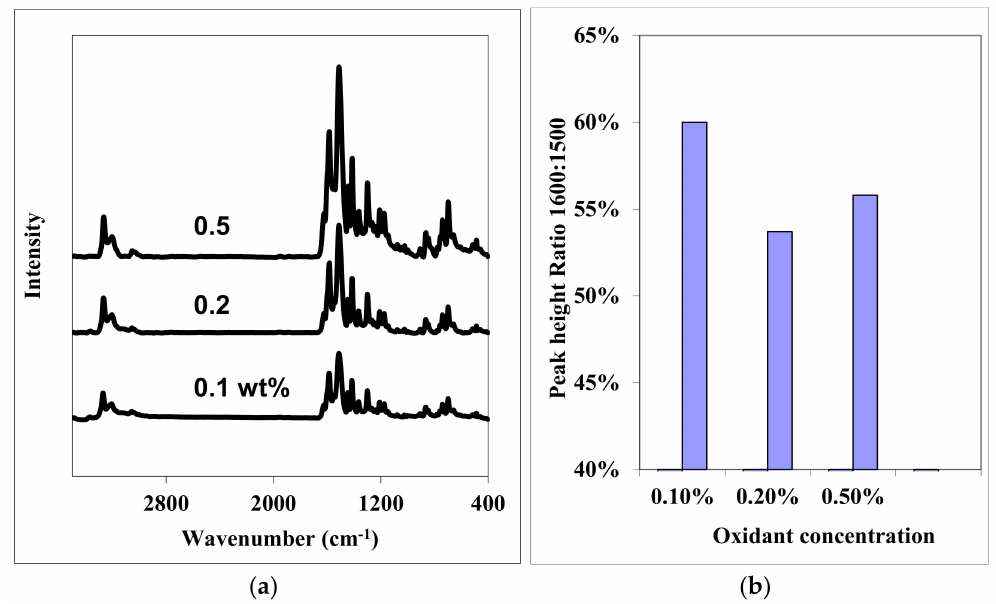
Figure 4. FTIR spectra of PANi at varying oxidant concentration ( a ) and ratio of 1600 and 1500 cm − 1 peak heights ( b ).